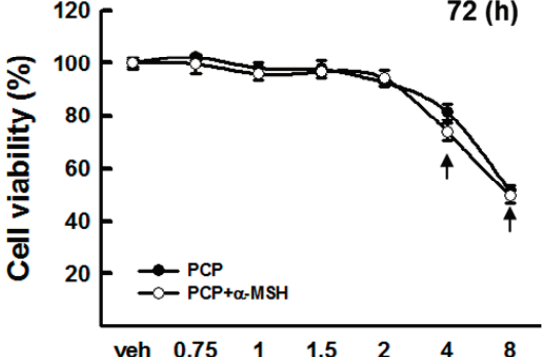
Figure 1. Cytotoxicity of pomegranate concentrate powder (PCP) in murine B16F10 melanoma cells. B16F10 cells were treated with various concentrations of PCP (0.75, 1, 1.5, 2, 4, and 8 mg/mL) in the absence or presence of α -MSH for 72 h. Values are expressed as the means ± SD from three independent experiments; PCP, pomegranate concentrate powder; α -MSH, α -melanocyte-stimulating hormone; and veh, vehicle control. Arrow indicates a significant ( p < 0.001) decrease in cell viability compared with the control (veh) using the LSD test.